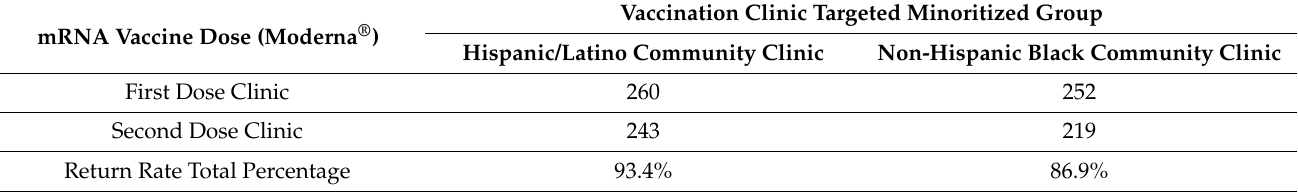
Table 2. Community vaccination clinic second dose return rate (mRNA vaccine).